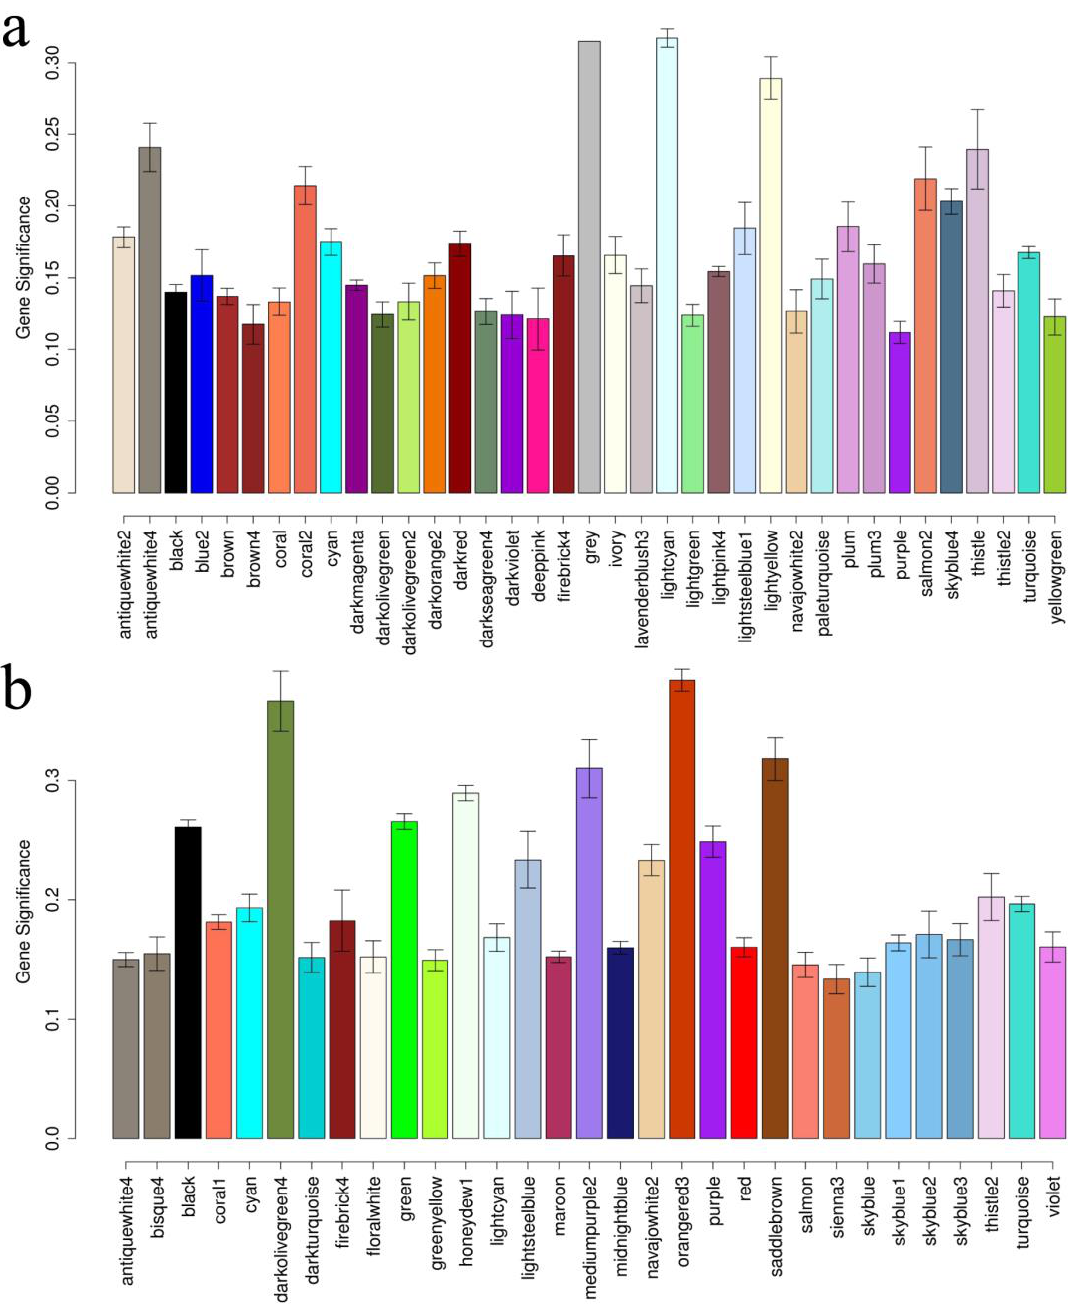
Figure 4. Relationship histogram between module and traits. ( a ): Relationship histogram between module and plant gross weight. ( b ): Relationship histogram between module and mid-parent valueof plant gross weight.